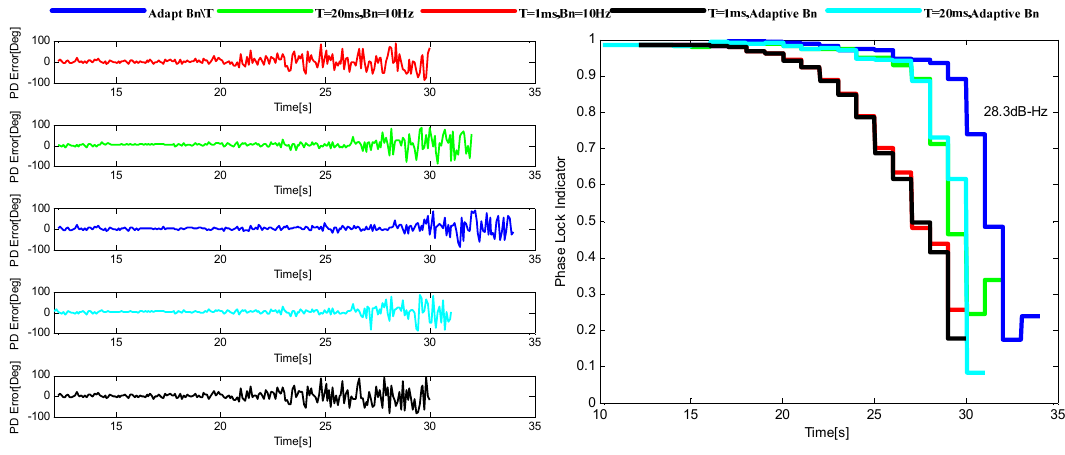
Figure 10. The output of PD ( left ) and the corresponding PLI ( right ) when p = 50 m/s 3 .